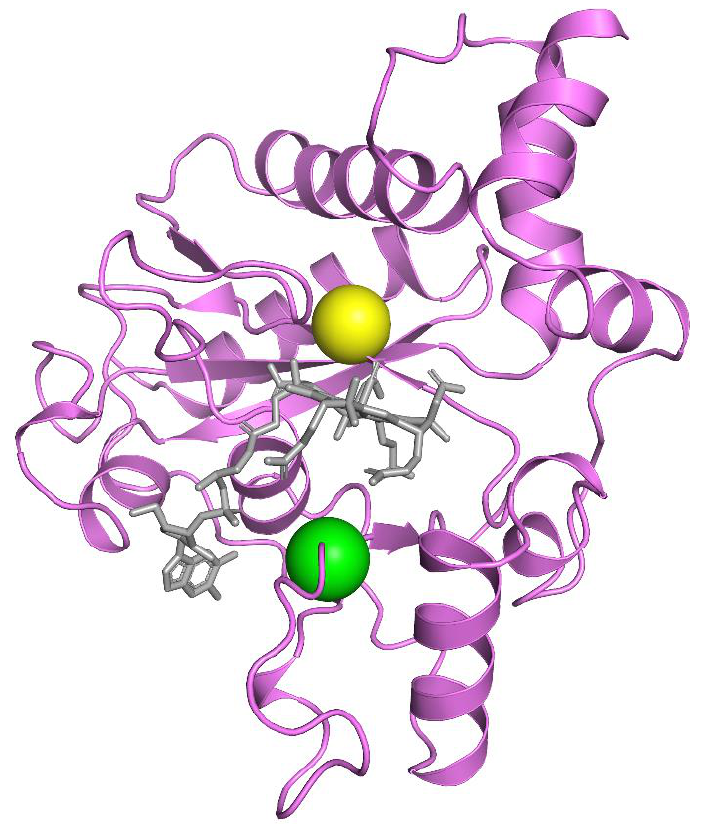
Figure 6. Crystal structure of the MMACHC -CNCbl complex, with the yellow ball at R161 and the green ball at G147.